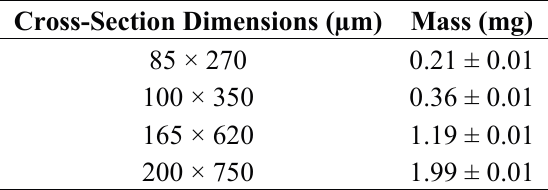
Figure 1. Typical cross-sectional image of a section of a flat Ge-doped optical fiber. At the centre of the fiber, indicated by the white line, is the location of the core containing the Ge dopant. Table 1. Respective mass for each cross-sectional form of doped